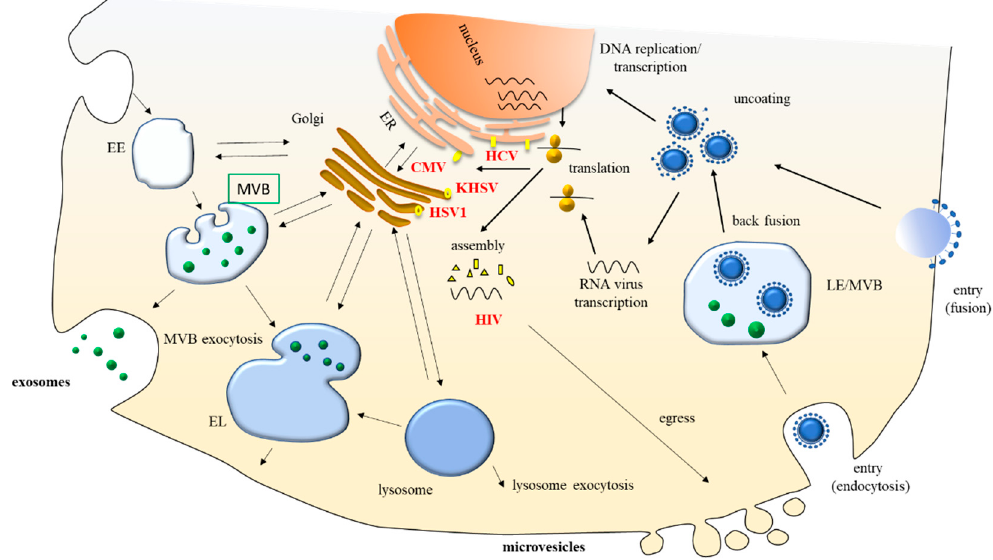
Figure 1. Common routes in virus life cycle and Extracellular Vesicle (EV) biogenesis and release. EV biogenesis requires certain components and takes place in cellular compartments that are in close communication with the assembly and release sites of viruses, despite differences in the biology of each virus, allowing the formation of vesicles containing viral elements. EE, early endosomes; MVB, Multivesicular Bodies; LE, Late Endosome; EL, Endolysosome; ER, Endoplasmic Reticulum; KSHV, Kaposi’s sarcoma-associated herpesvirus; EBV, Epstein–Barr virus; CMV, Cytomegalovirus; HSV1, Herpes simplex virus; HIV, Human immunodeficiency virus; HCV, Hepatitis C virus.